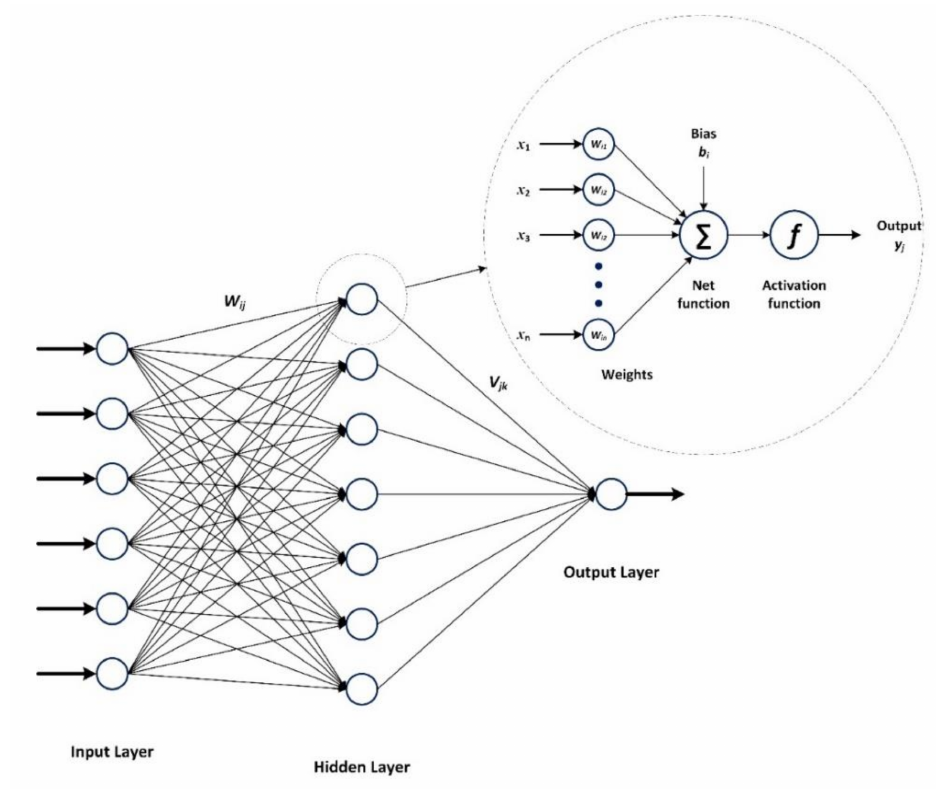
Figure 9. Schematic of MLP and